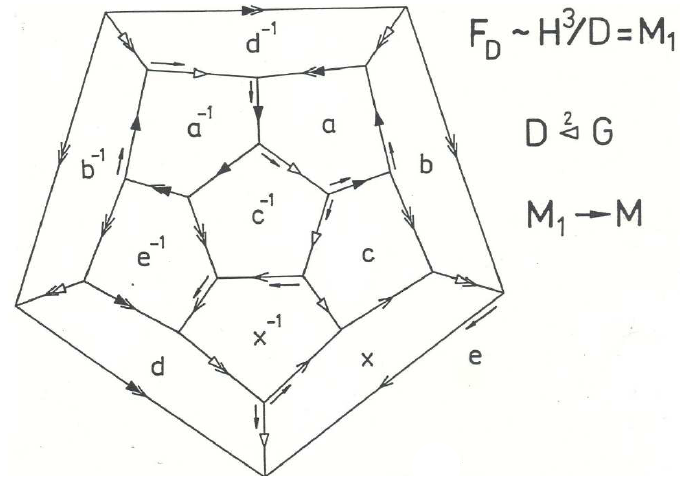
Figure 5. Twofold covering the football manifold as a hyperbolic dodecahedron